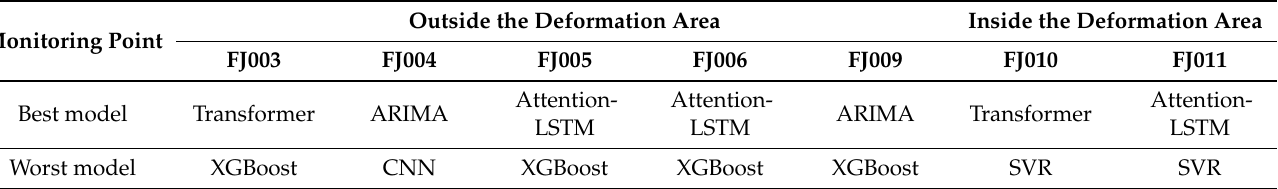
Figure 9. Prediction performance of the models when using different evaluation metrics. ( a ) MAE, ( b ) R 2 , ( c ) MAPE, ( d ) RMSE. Table 6. The best and worst prediction models for displacement data within and outside the local deformation